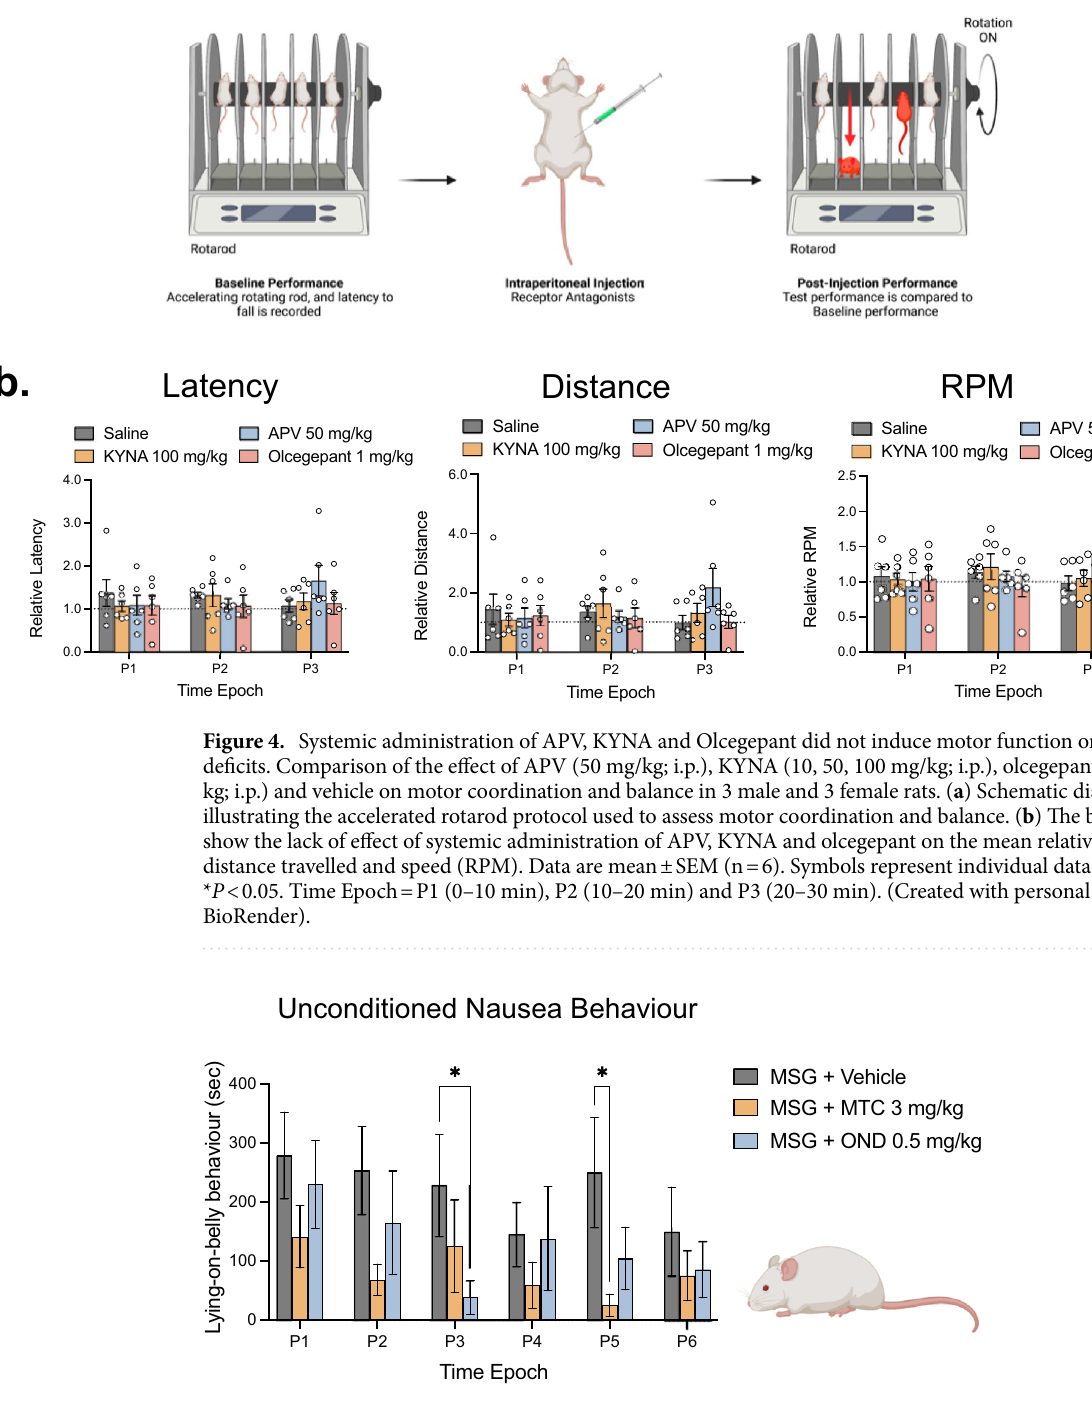
Figure 5. OND and MTC ameliorated MSG—induced nausea behaviours in male rats. The effects of MTC (3 mg/kg; i.p.), OND (0.5 mg/kg; i.p.) and vehicle in combination with MSG (1000 mg/kg; i.p.) on MSG induced LOB behaviour duration in 6 male rats. Both MTC and OND lowered LOB behaviour, but significant changes occurred at P3 and P5, for each agent, respectively. Data are mean ± SEM (n = 6). *P < 0.05. Time Epoch = P1 (0–10 min), P2 (10–20 min), P3 (20–30 min), P4 (30–40 min), P5 (40–50 min) and P6 (50–60 min) post